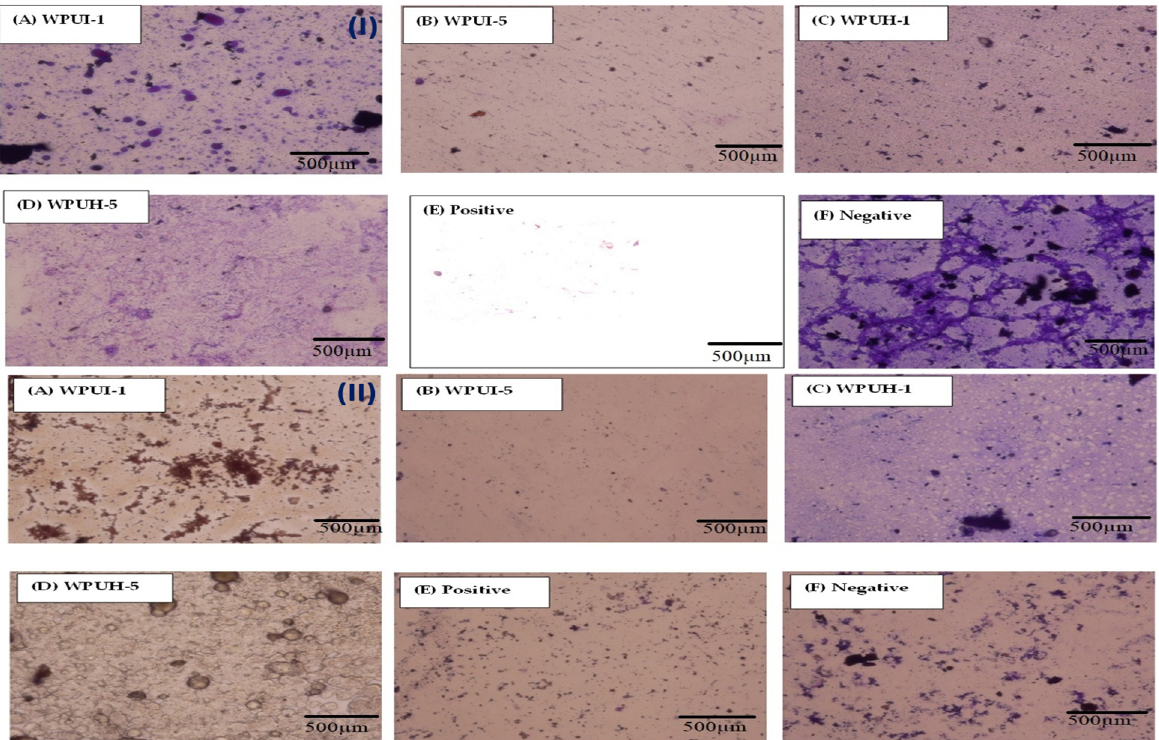
Figure 7. Phase contrast microscopy showing the pattern of bacterial biofilm formation and its inhibition ( I ). ( A , B ) WPUI-treated slides. ( C , D ) WPUH-treated slides. ( E ) Positive growth and ( F ) negative growth against E. coli biofilm. ( II ) ( A , B ) WPUI-treated slides. ( C , D ) WPUH-treated slides. ( E ) Positive growth and ( F ) negative growth against S. aureus